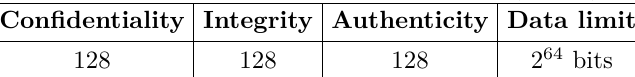
Table 6: Security claims of WAGE - AE -128 (in bits)